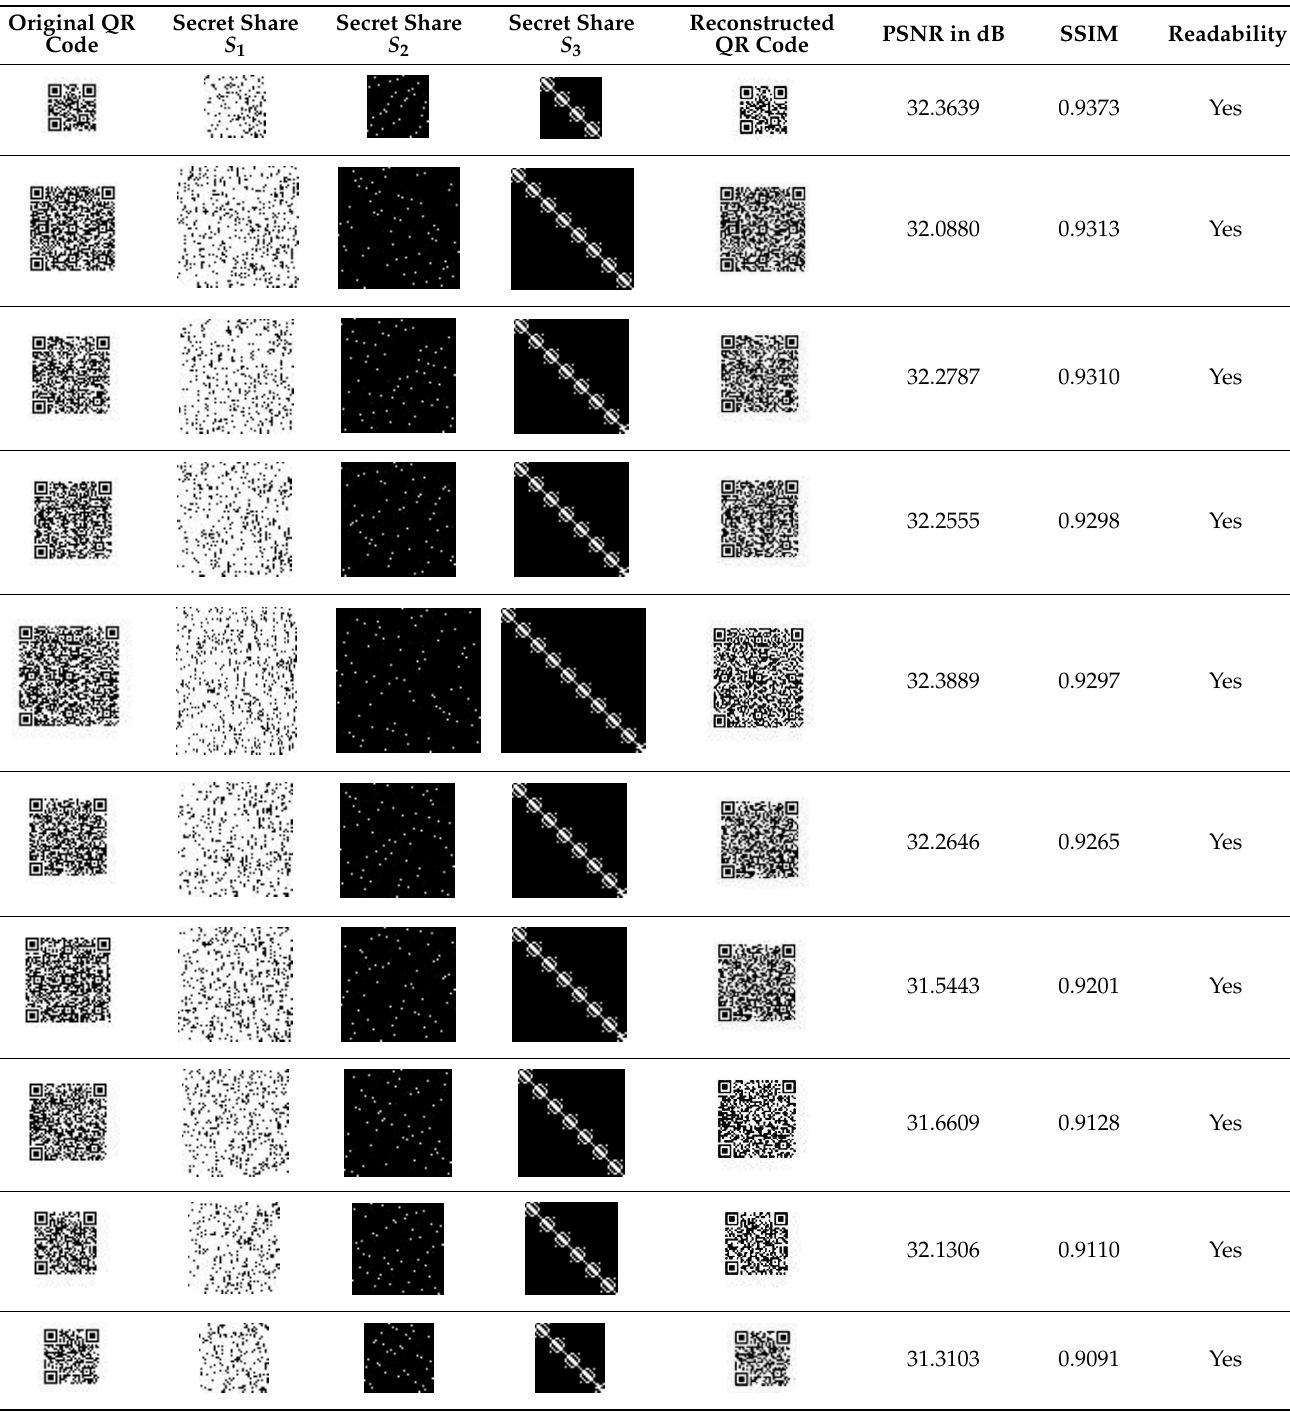
Table 2. Experimental results for QR code sharing and reconstruction.